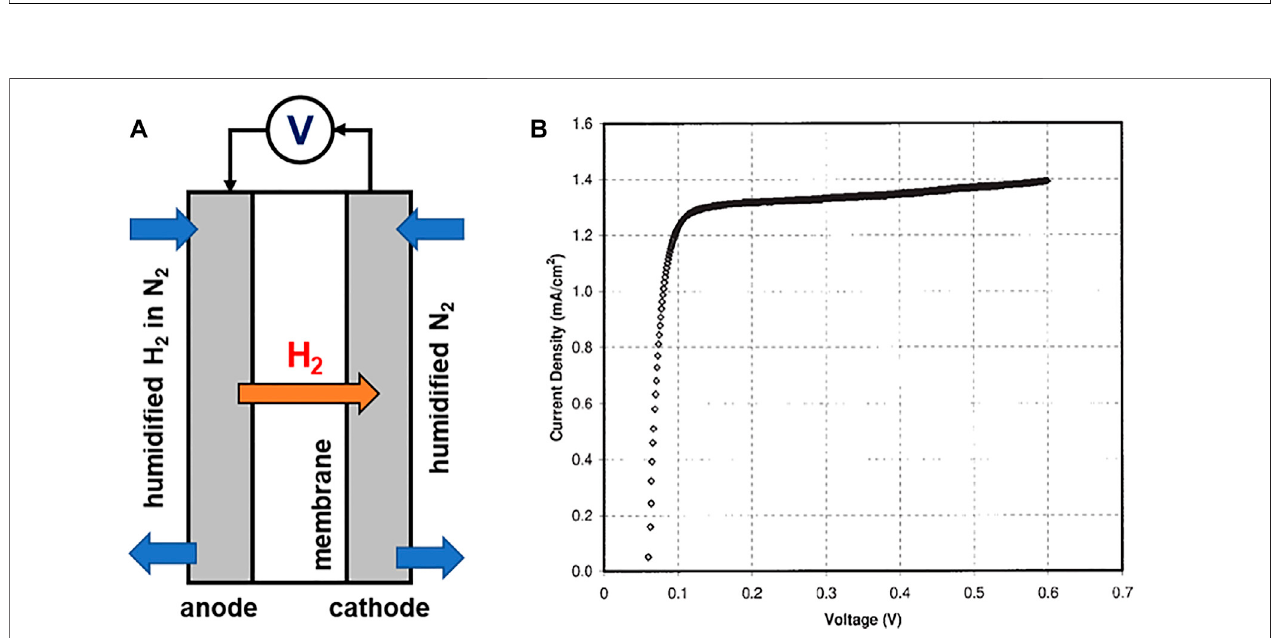
FIGURE 3 | Representative experimental set up for (A) in situ MEA measurement for hydrogen permeation and (B) example of linear sweep voltammogram to measure the hydrogen crossover current density (Kocha et al., 2006. Copyright 1999 – 2022 John Wiley & Sons, Inc.).